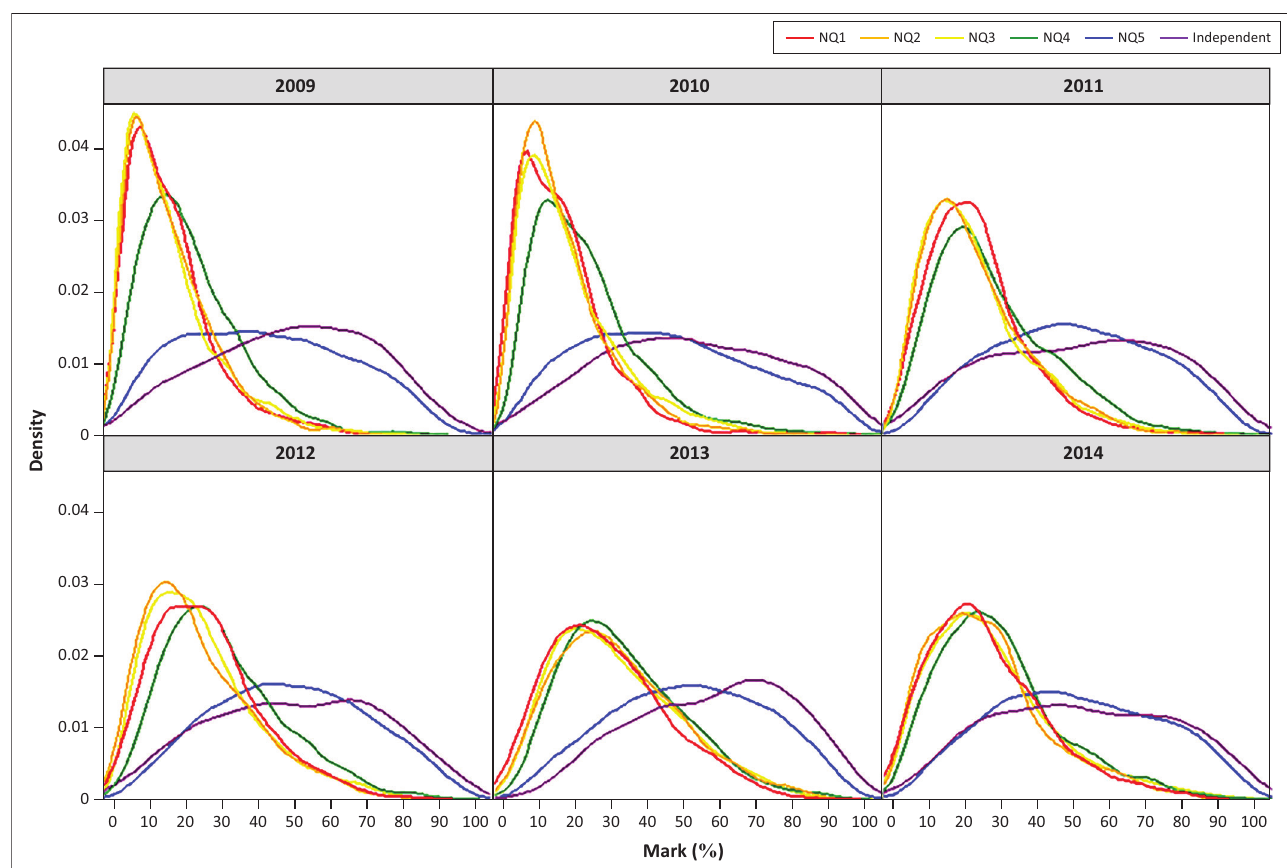
FIGURE 1: Distribution of mathematics examination marks by school quintile type 2009–2014 for learners in the Western